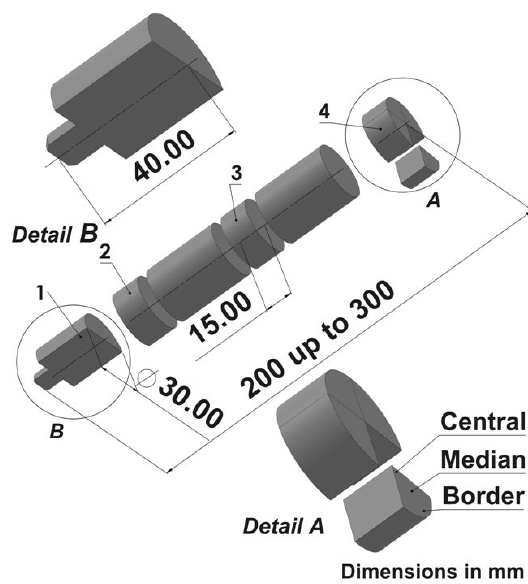
Figure 2. Schematic diagram showing the different regions of the ingot. (1) (Detail A) bottom section of the ingot in contact with the extractor device, where there is a transient heat-transfer regime; (2) proximal, (3) medial and (4) distal sections, where there is a steady-state heat transfer regime; (detail B) radial locations (centre, middle and edge) analyzed for regions 1 to